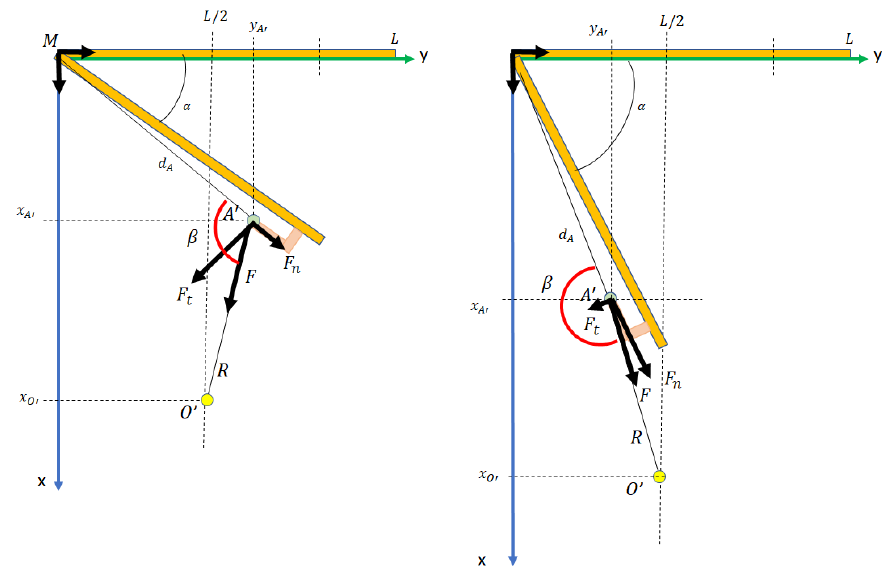
Figure 13. Illustration of forces undergone by the handle during the pulling process. Two moments are shown. In the left-hand picture, the tangential force is sufficiently great to make the door rotate. In the right-hand picture, the tangential force is small and the door will probably not